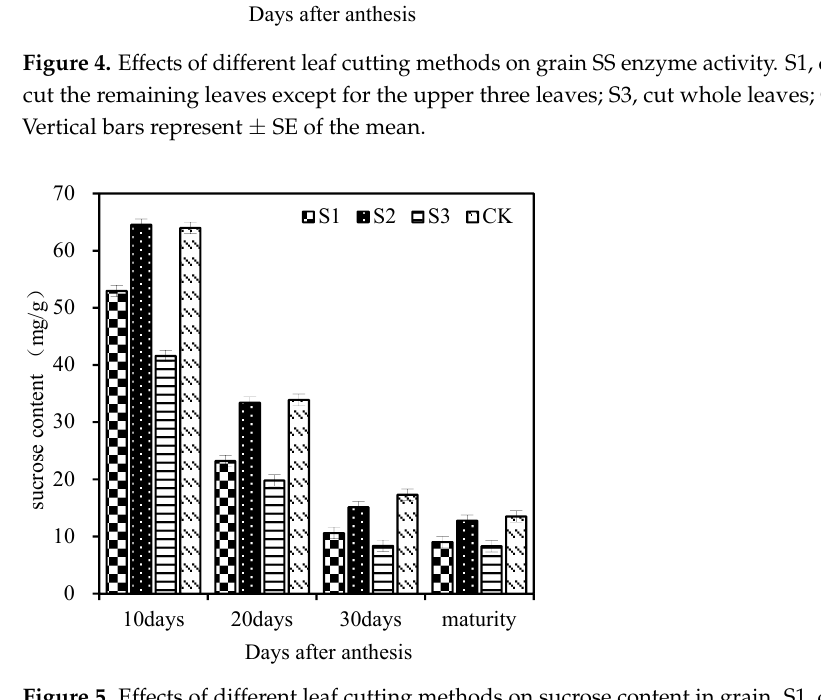
Figure 5. Effects of different leaf cutting methods on sucrose content in grain. S1, cut three leaves; S2, cut the remaining leaves except for the upper three leaves; S3, cut whole leaves; CK, normal plants. Vertical bars represent ± SE of the mean.